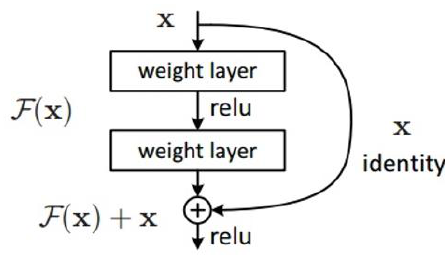
Figure 1. The structure of residual block.